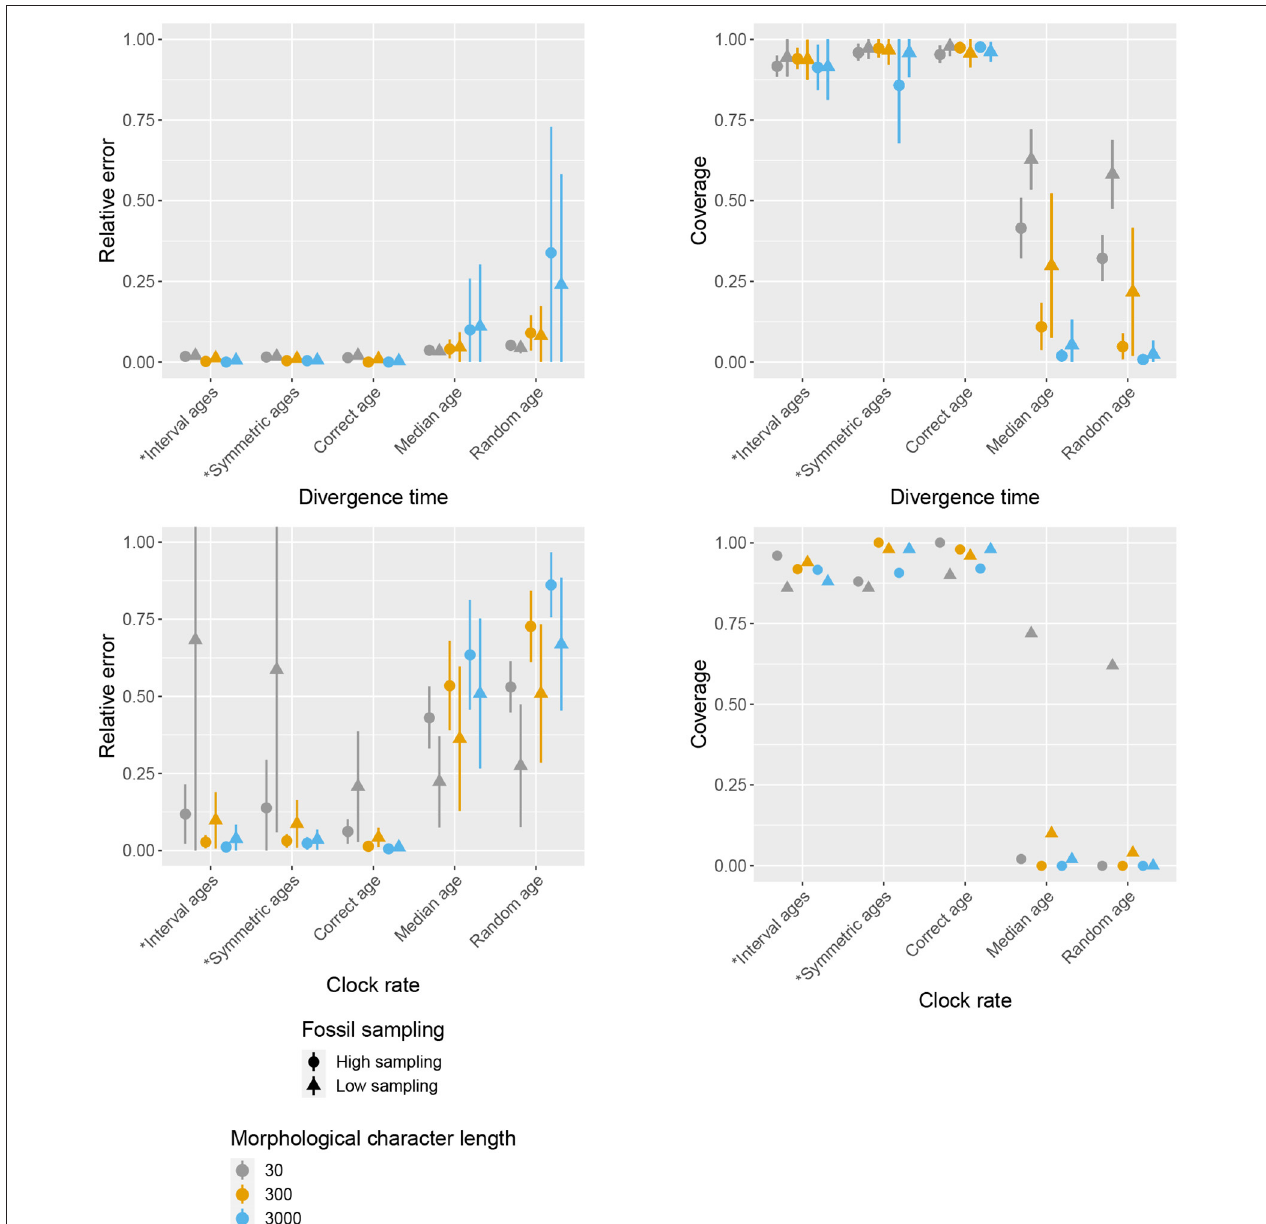
FIGURE 3 | Impact of character and fossil sampling on divergence times and clock rate. The mean and standard deviation of the relative error of median posterior estimates (left) , and the mean 95 % HPD coverage (right) are shown for different age handling methods, different character sampling, and different fossil sampling settings. Ages sampled as part of the MCMC are marked by